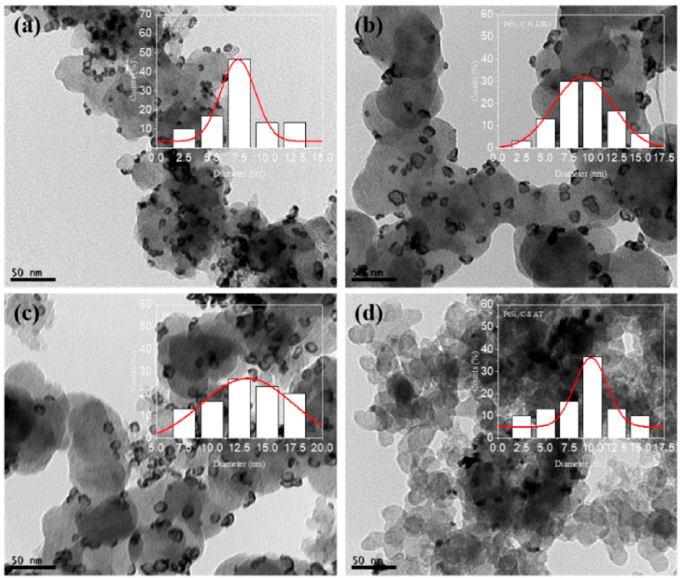
Figure 3. TEM images of ( a ) PtNi/C–H AT, ( b ) PtNi 2 /C–H AT, ( c ) PtNi 3 /C–H AT, and ( d ) PtNi 3 /C–S AT.